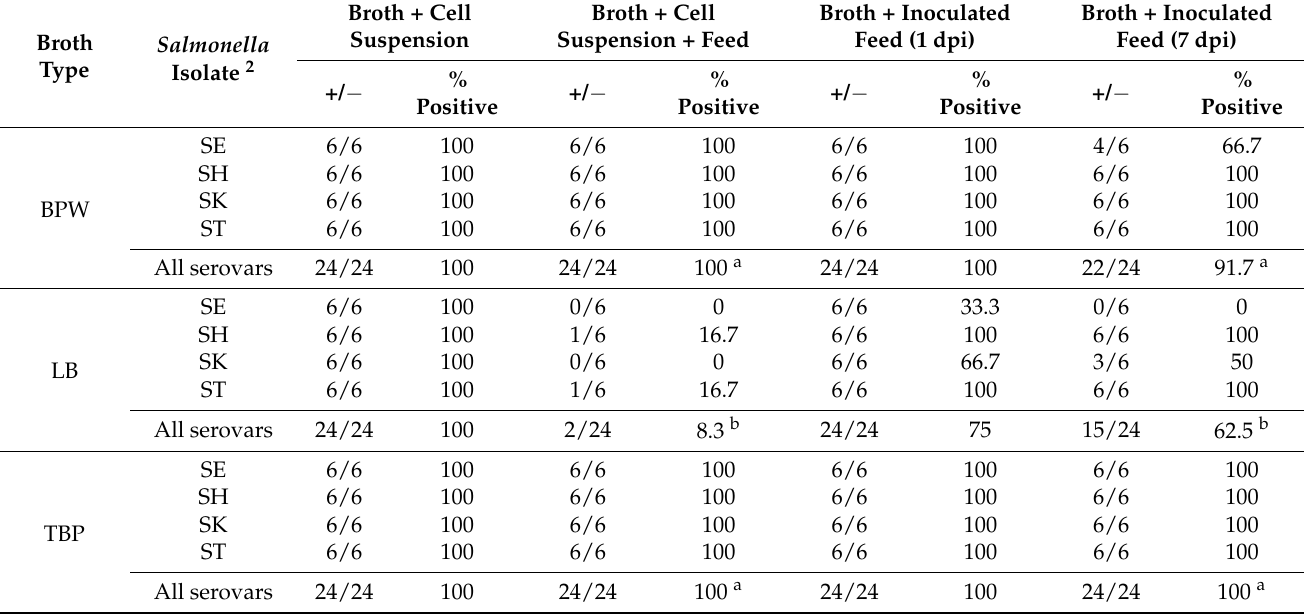
Table 3. Salmonella recovery from pre-enrichment broths after 22 ± 2 h incubation at 37 ◦ C 1 .